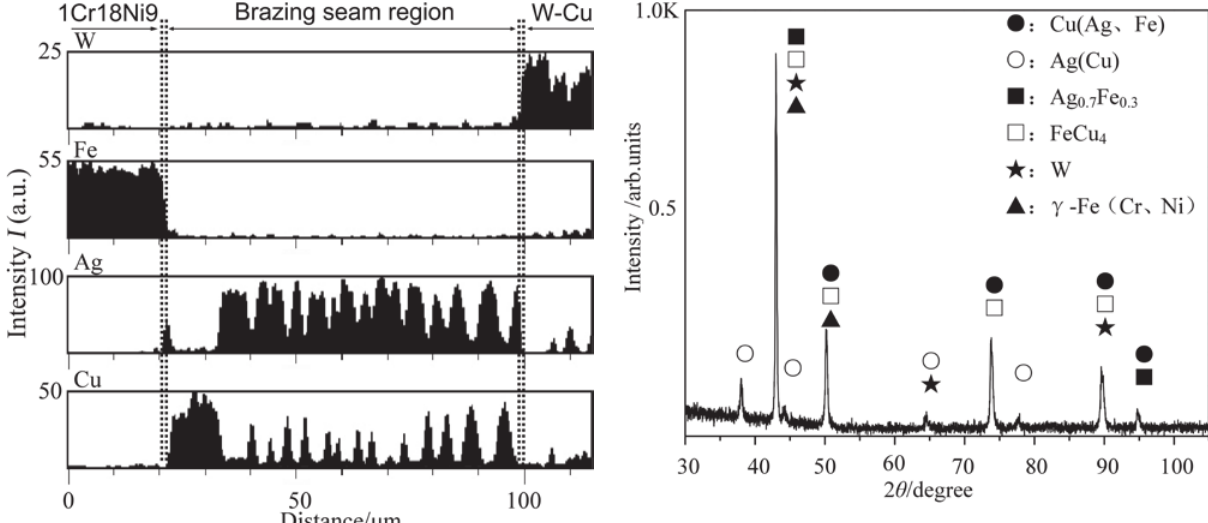
Fig. 8: X-ray diffraction